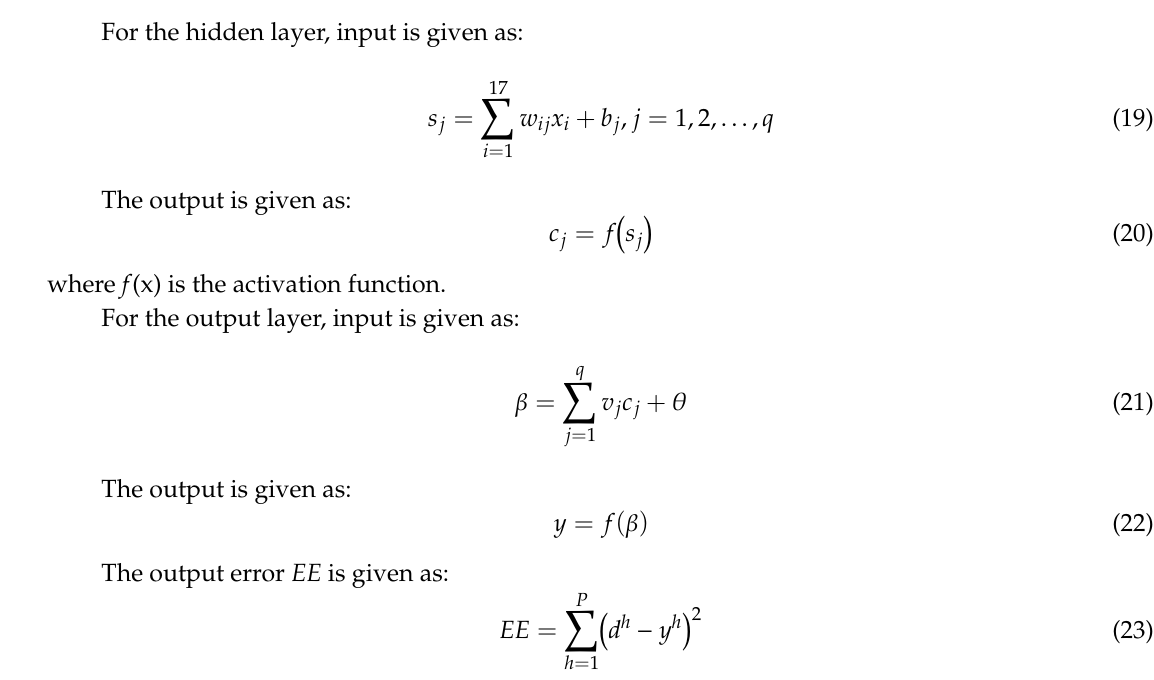
Figure 2. The back-propagation (BP) neural network structure.